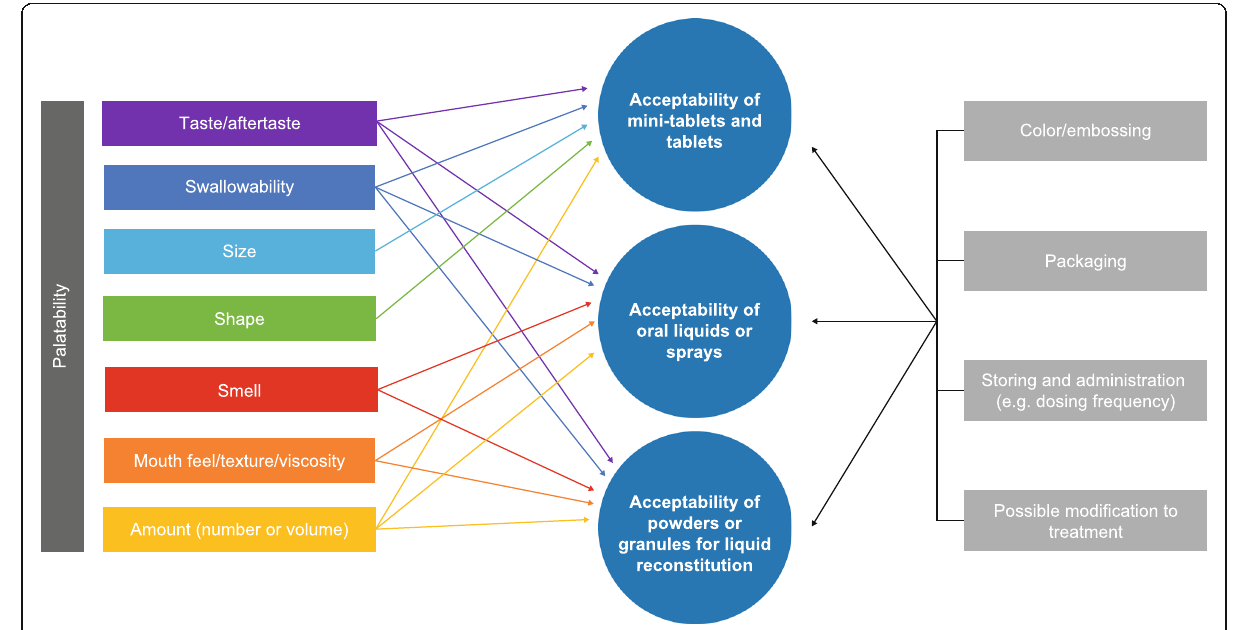
Fig. 2 Draft conceptual model of targeted oral formulation acceptability attributes following advisory